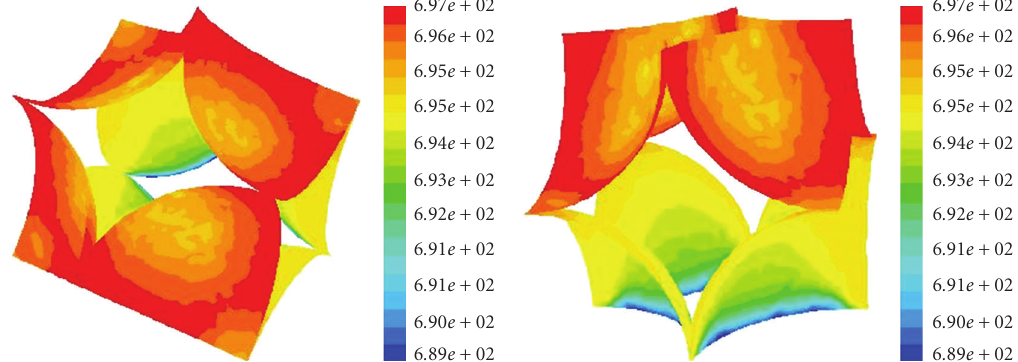
Figure 14: Two views of the wall temperature distribution (in Kelvin degrees) for SC cell “trs1” (LOFA—Average Channel).